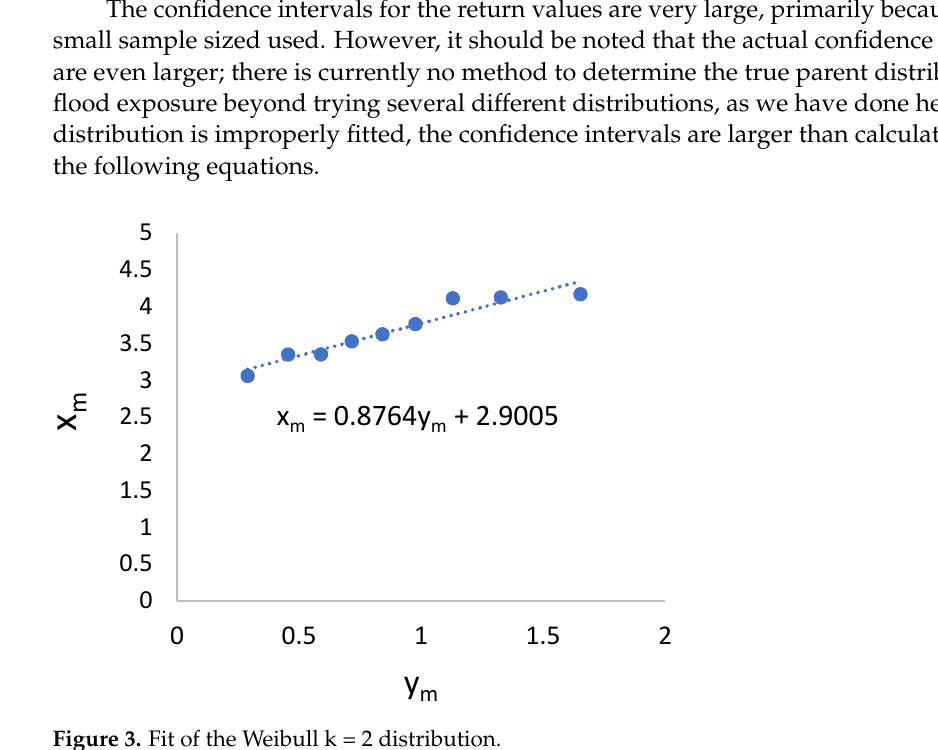
Figure 3. Fit of the Weibull k = 2 distribution.